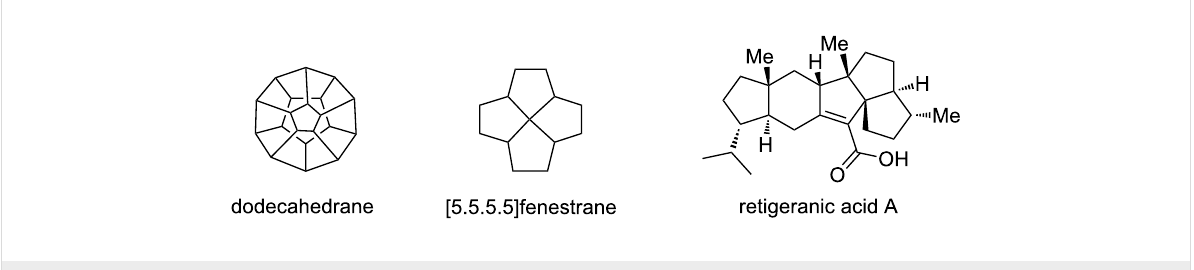
Figure 1: Natural and non-natural products containing quinane systems.